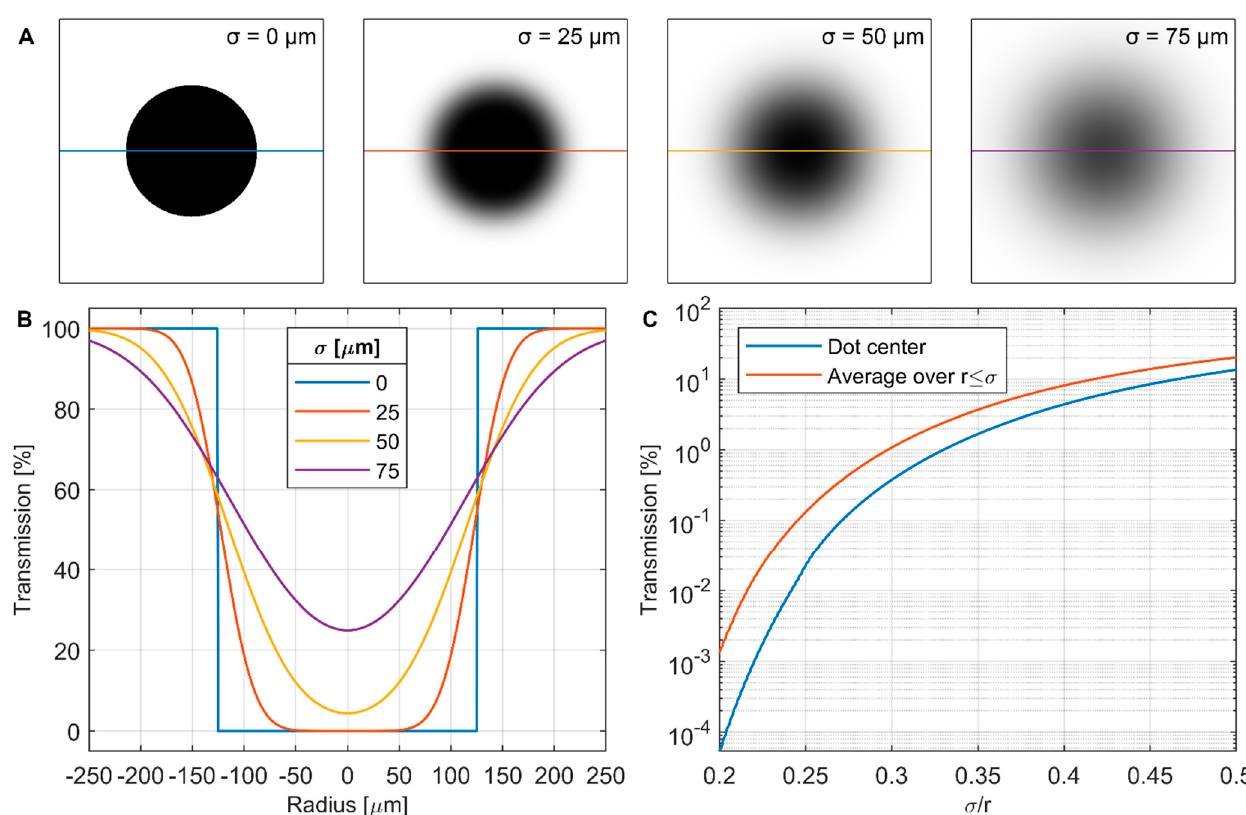
Figure 12. Effect of image blur on apparent transmission of a circular black body. ( A ) Model images of a perfectly opaque 250 μ m diameter dot blurred with Gaussian function of increasing standard deviation σ . ( B ) Transmission profiles through each image from ( A ). ( C ) Generalized transmission at center of a dot radius r as a function of σ / r and average over a center region r ≤ σ